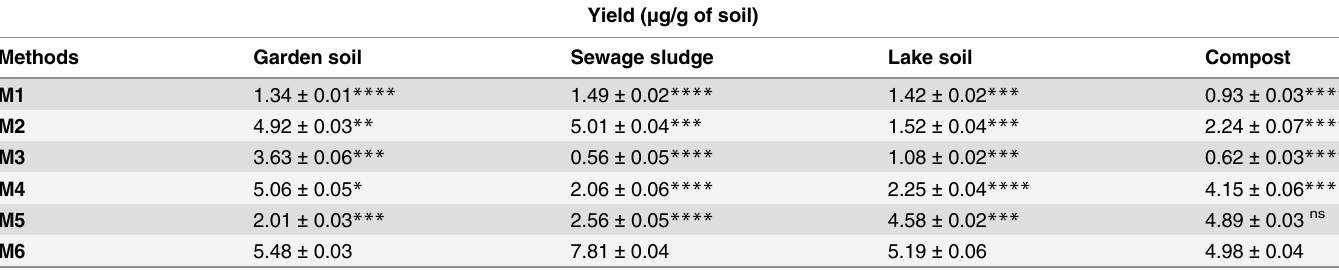
Table 3. Assessment of yield of metagenomic DNA obtained by methods M1 to M6 for different soils.